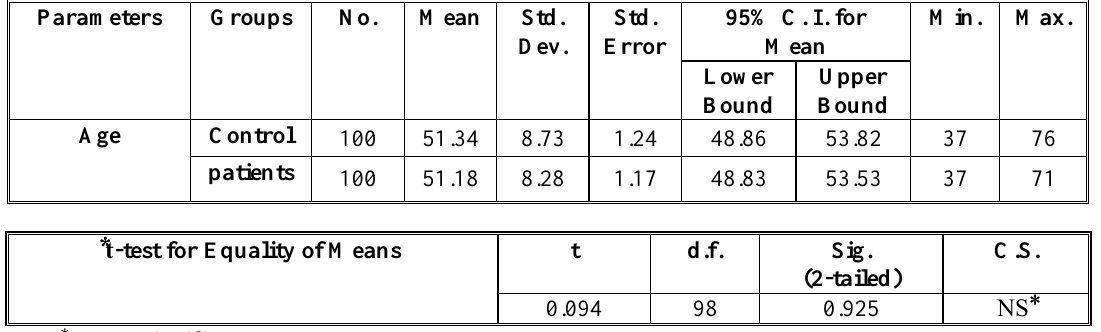
Table (1) Distribution of studied groups according to mean age /